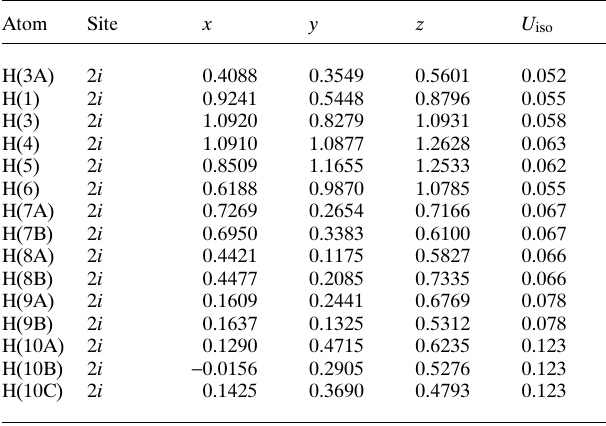
Table 2. Atomic coordinates and displacement parameters (in Å 2 )